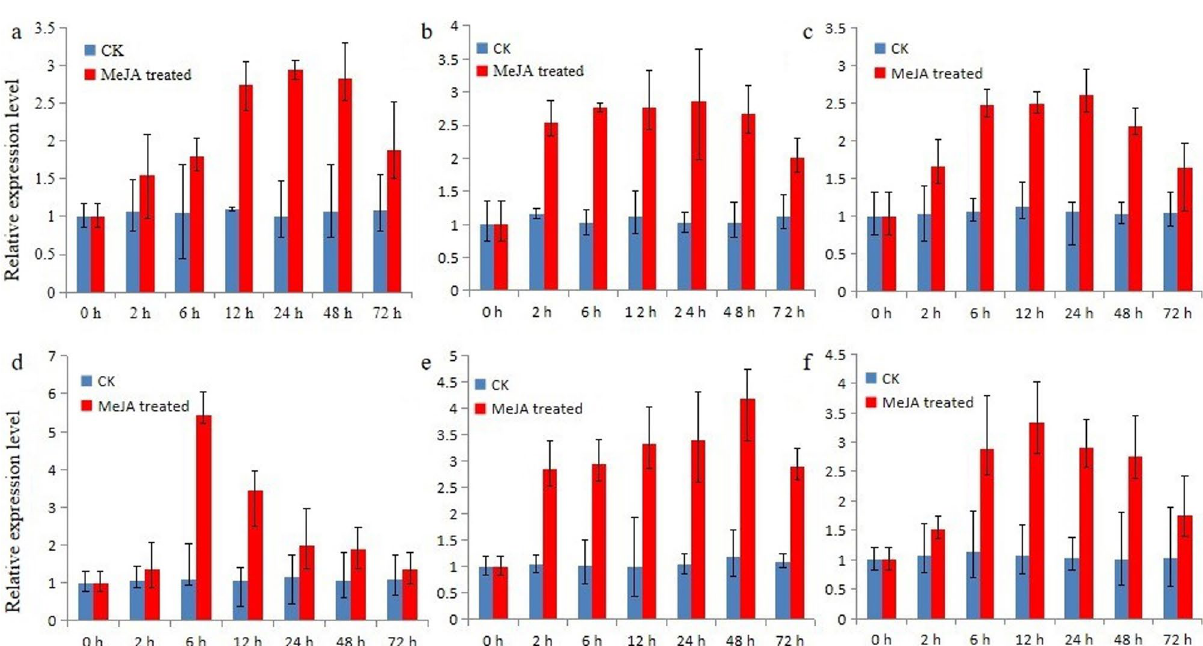
Figure 8. Level of SaAACT ( a , b , c ) and SaHMGS ( d , e , f ) transcripts in Santalum album roots ( a , d ), shoots ( b , e ) and leaves ( c , f ) after induction by 100 mM MeJA. The expression level of SaAACT and SaHMGS genes in the untreated control (CK) was set to 1. Data from qRT-PCR are means ± SD (standard deviation) from triplicate experiments (n =